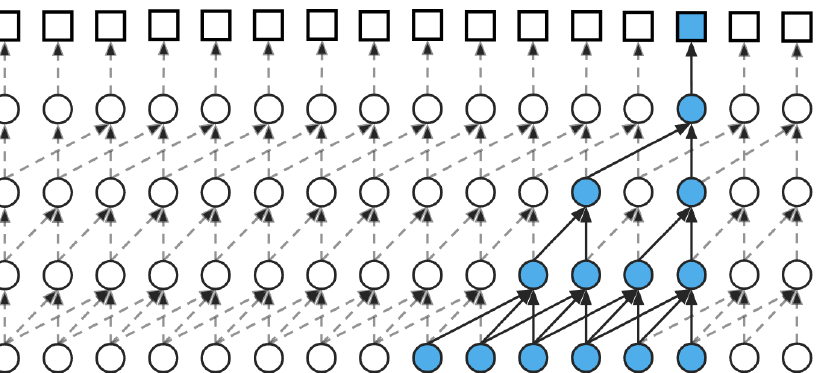
Figure 7. Learning process of slow fusion (Note: Blue denotes the number of nodes needed in current operation).